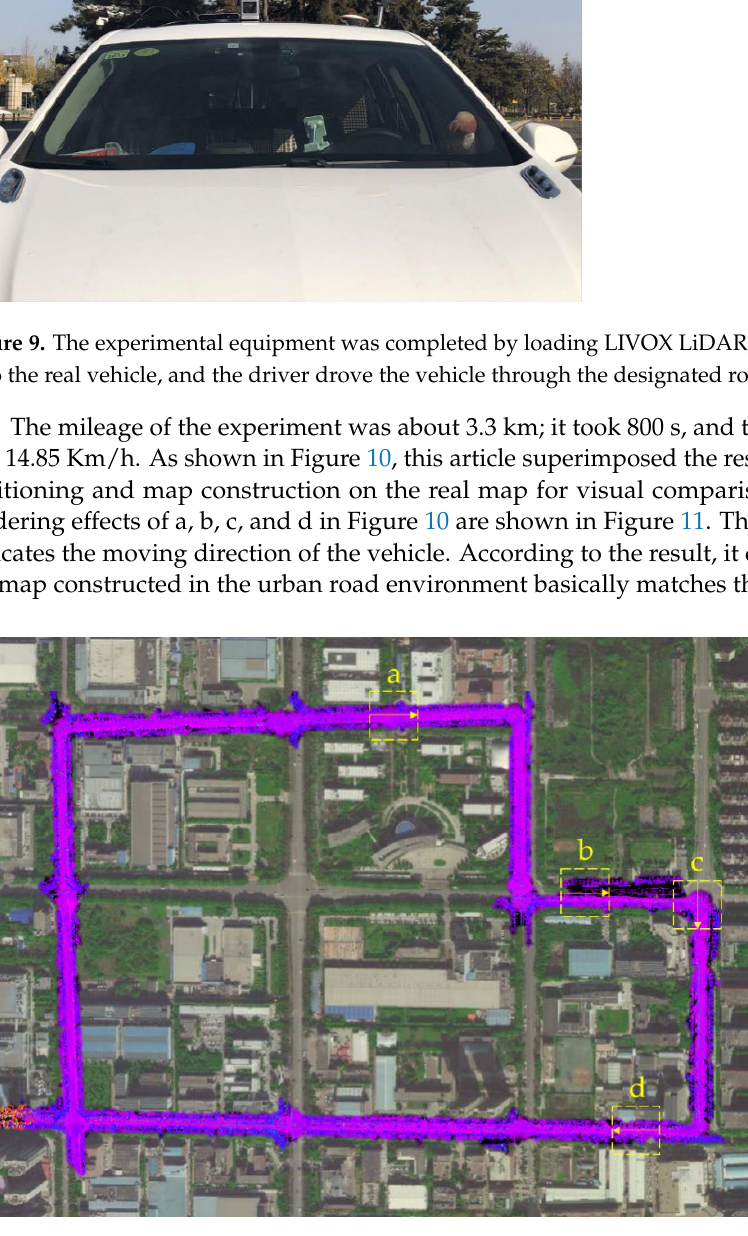
Figure 10. The VIAL-SLAM map aligned with Google Earth.